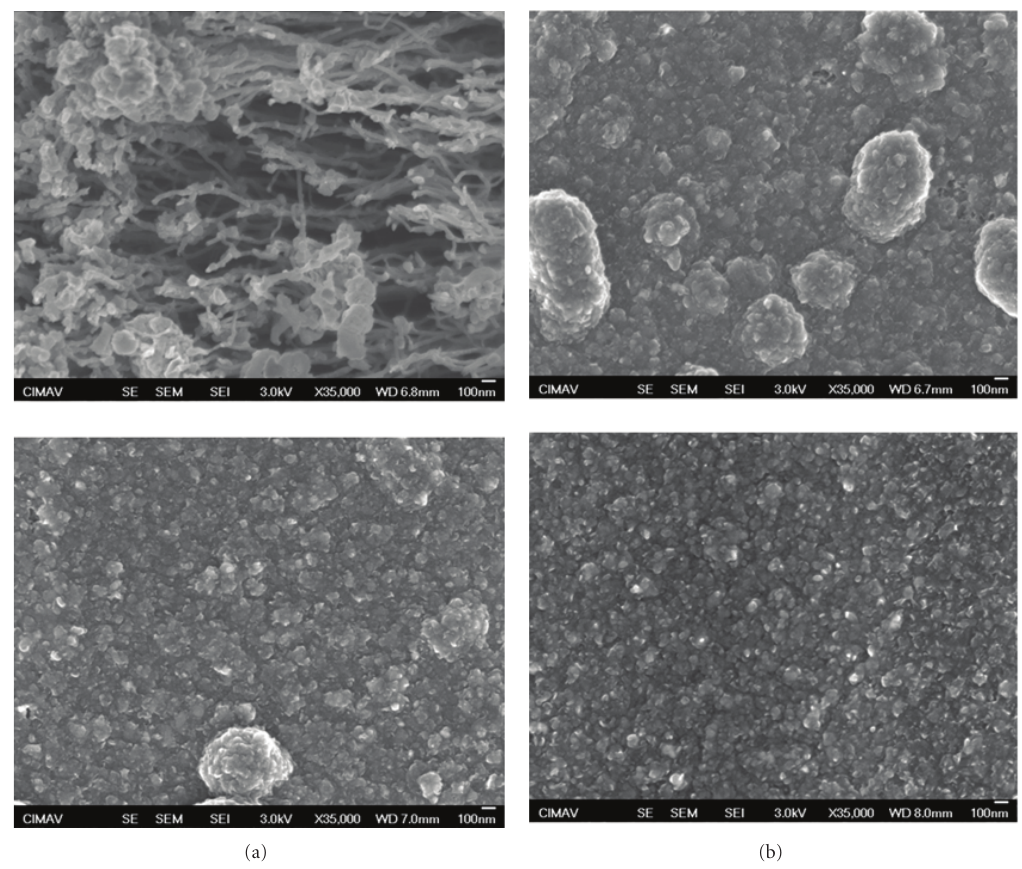
Figure 8: SEM images carbon nanotubes synthesized to 900 ◦ C of the four zones analyzed.